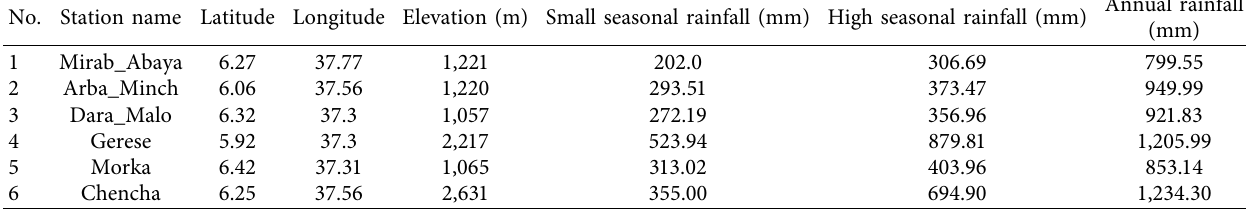
Table 1: Meteorological stations information of the study